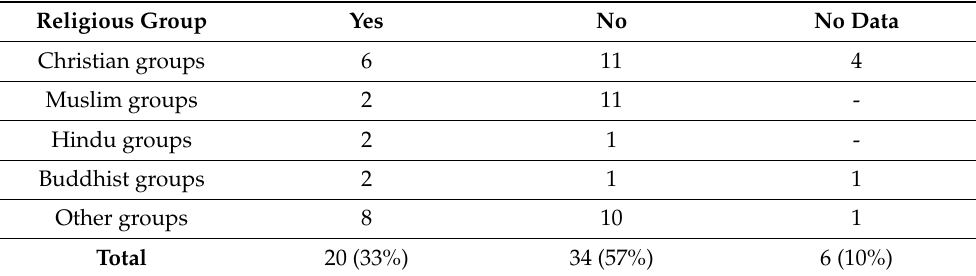
Table 1. Research question 1: Were there any activities in your buildings after the Minister of Church Affairs requested that religious buildings were closed to the public (e.g., sacrifices, recordings of sermons, and rituals for smaller congregations)?